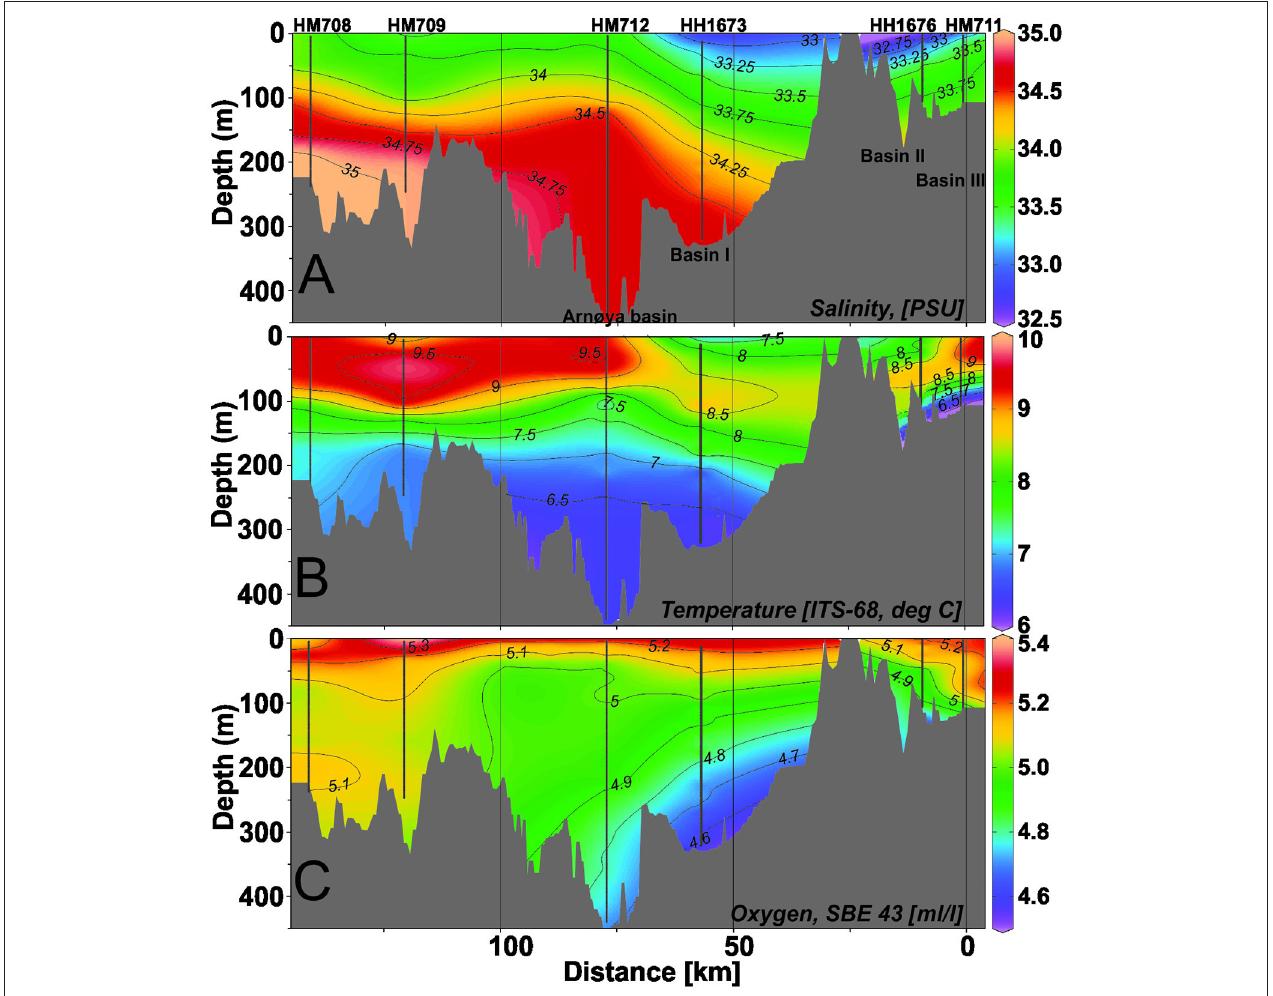
FIGURE 4 | Hydrographic conditions along a transect from the outer coastal areas in the north (left), the Arnøya basin (center) and Lyngenfjord basins in the south (right), during October–November 2015. Research vessel ctd-station numbers on top of the figure with prefix HM (RV Håkon Mosby) and HH (RV Helmer Hanssen), respectively. (A) Salinity (psu), (B) Temperature ( ◦ C), (C) Oxygen (ml · l − 1